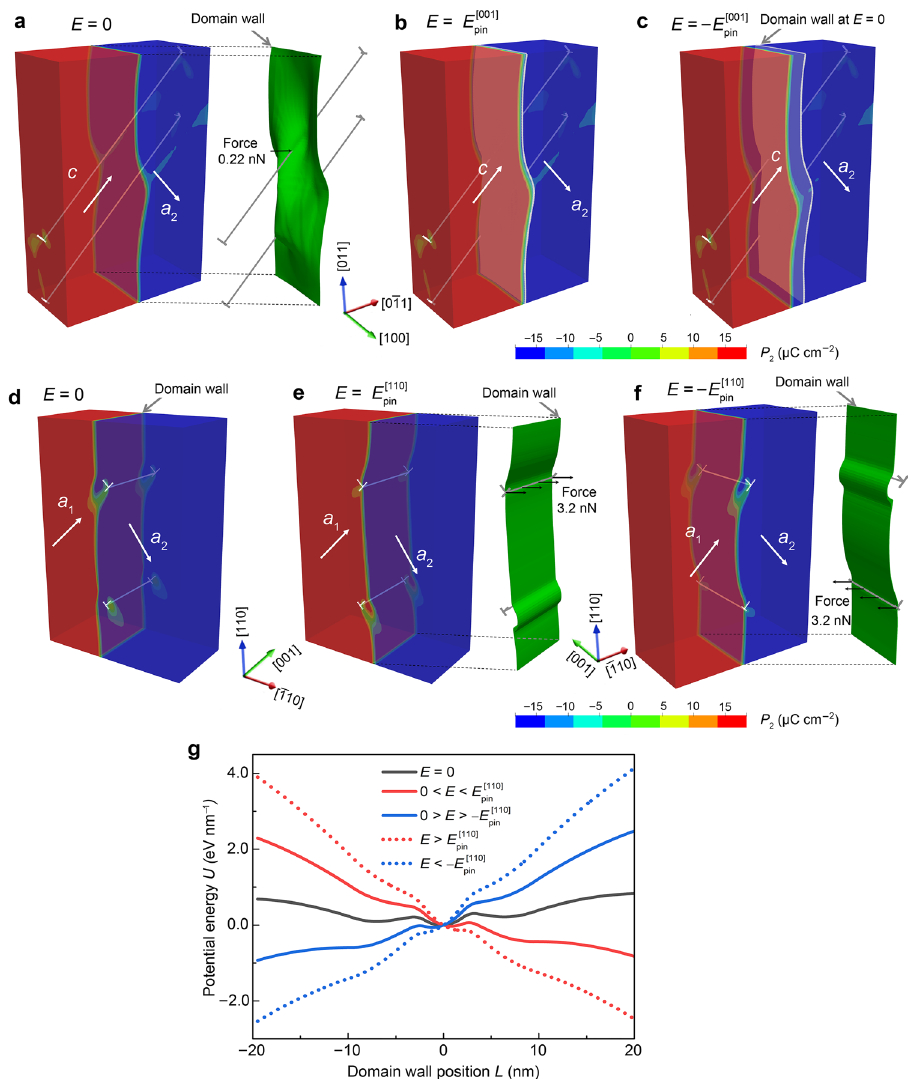
Fig. 4 | Understanding ofanisotropic DDW interactions. Phase- fi eld simulations of the 0-dim/2-dim interaction in (001)-cut deformed sample under different amplitude of AC fi elds along the [001] direction (that is, parallel to the dislocation linevector), a E =0, b E = E 001 ½ (cid:2) pin ,and c E = (cid:3) E 001 ½ (cid:2) pin .Inthiscase,thelocalpinningforce exertedontheintersectionpointsismuchsmaller.Asaresult,thedomainwallcan be easily moved to the right side of the initial position under E = E 001 ½ (cid:2) pin in b , or the left side of the initial position at E = (cid:3) E 001 ½ (cid:2) pin in c . Therefore, the 90° domain wall moves towards the 00 (cid:1) 1